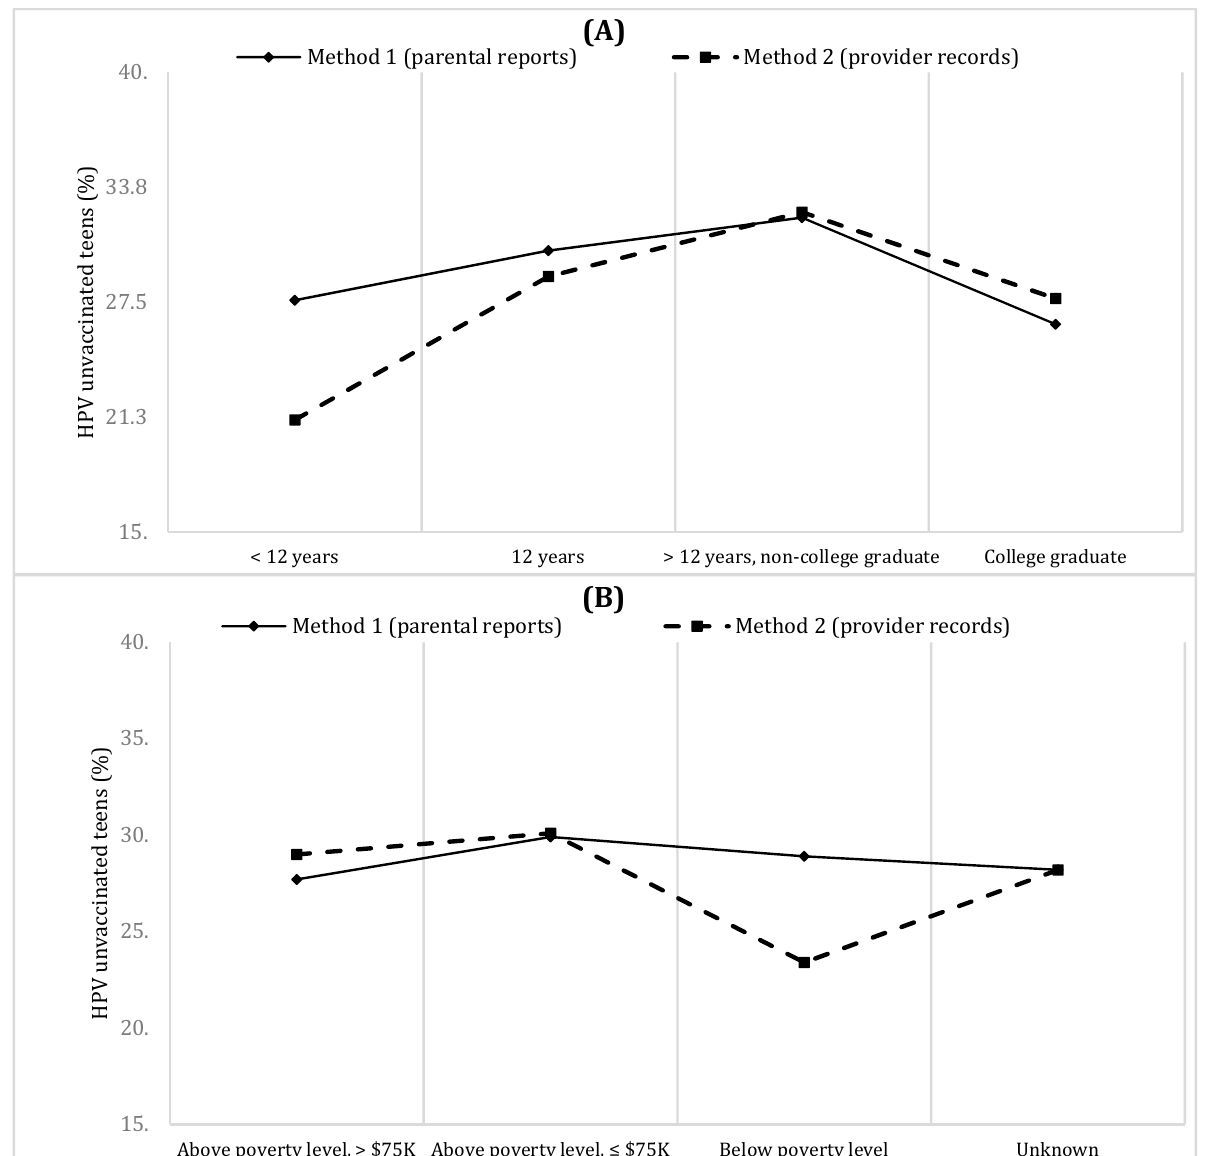
Figure 3. The distributions of the proportion of HPV-unvaccinated teens according to ( A ) mother’s education and ( B ) annual family income in Subsample A (N = 18,788). Method 1: parent-reported vaccination status. Method 2: provider-reported vaccination record. HPV: human papillomavirus. The biggest differences in the proportion of unvaccinated teens between Methods 1 and 2 were observed in the lowest SES groups (<12 years and below poverty level).